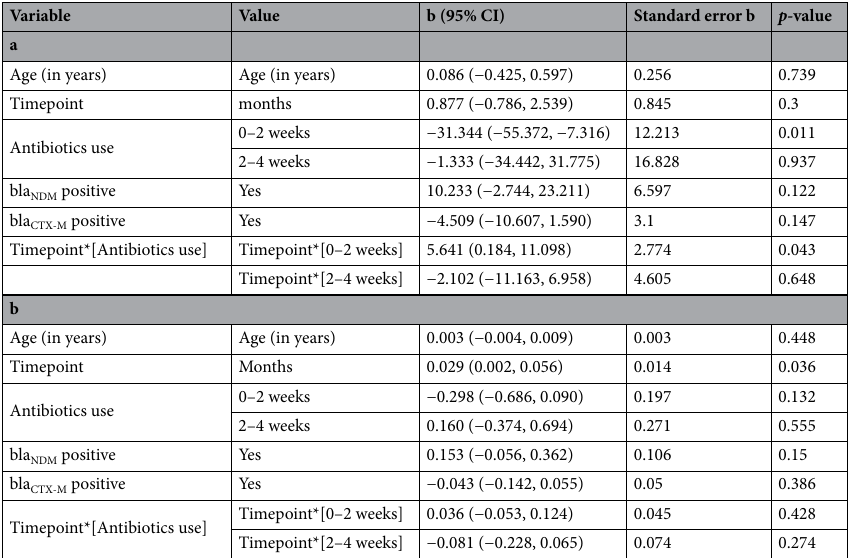
Table 1. Linear mixed effects models to test for the effects of antibiotic use, age, and time points on alpha diversity. ( a ) The effects of antibiotic use on species richness (Observed), ( b ) on biodiversity (Shannon index).